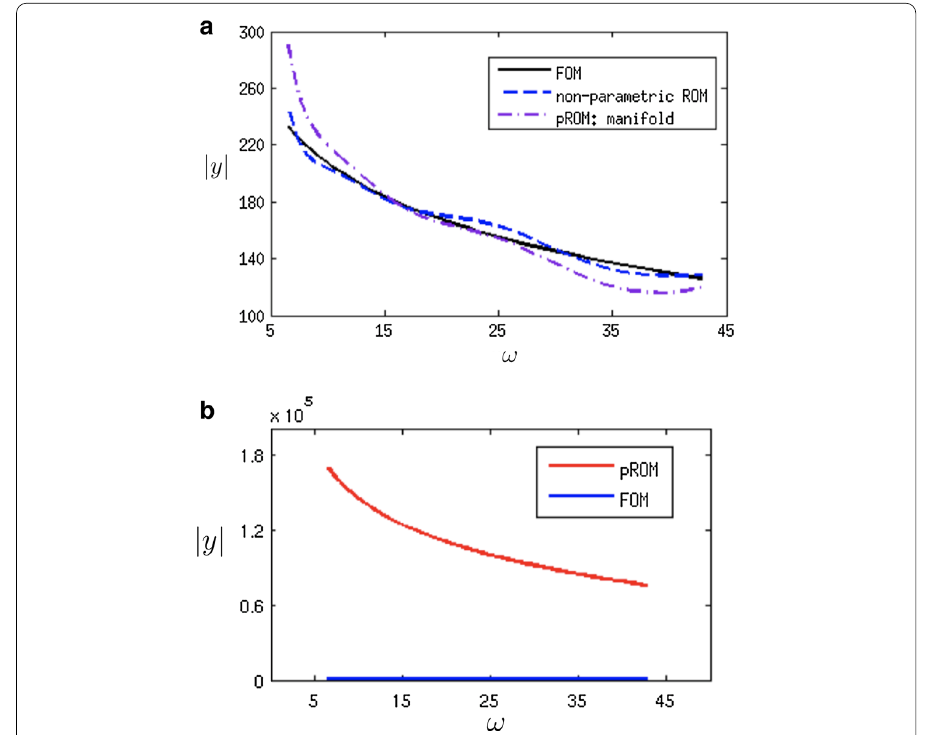
Fig. 3 The behavior of ROMs built by interpolation on the nonsingular matrix manifold. a The ROM with k = 10 and p ∗ = 65 . 51. b The ROM with k = 11 and p ∗ = 65 . 51